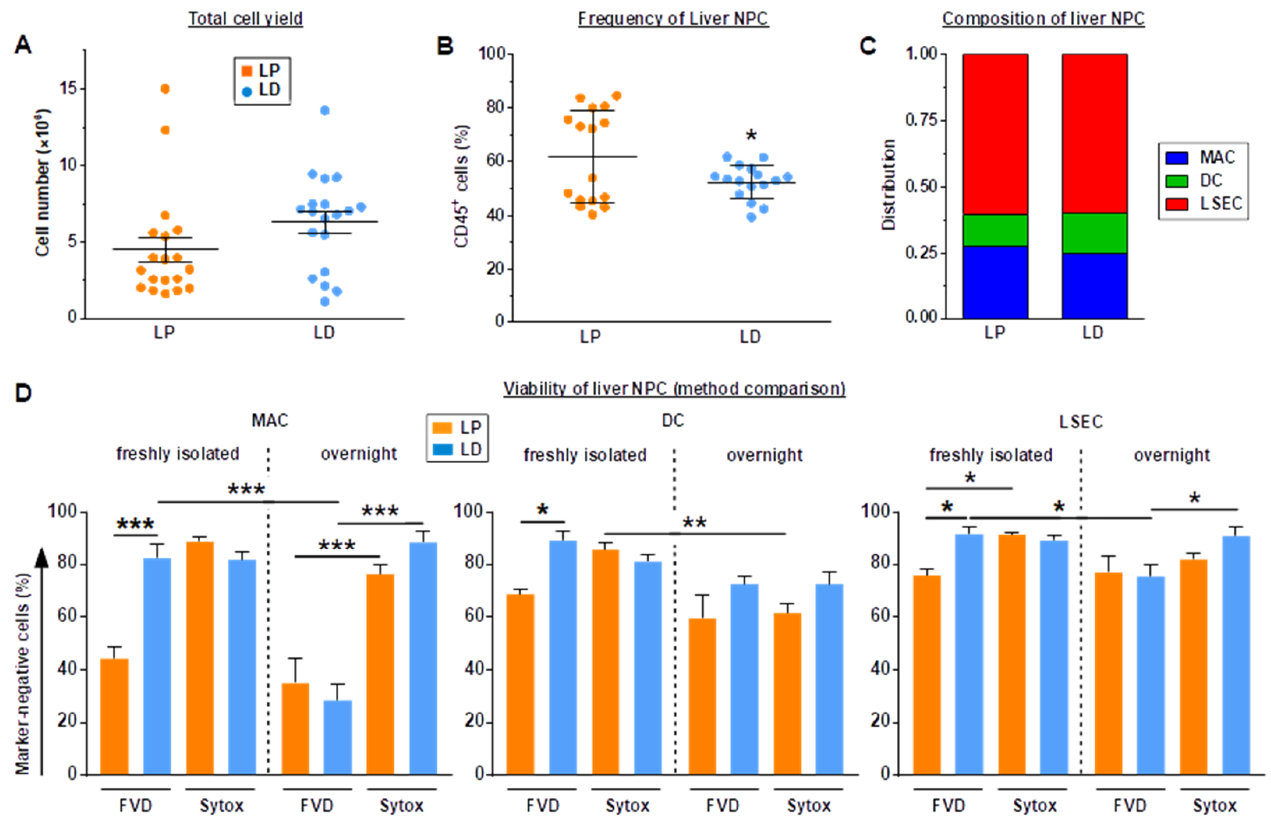
Figure 2. LP and LD yield comparable numbers and composition of liver NPCs, but LD-enriched cells appear dead when using FVD. ( A ) Total cell yield obtained after density centrifugation (mean ± SEM, each n = 19). ( B ) Frequencies of CD45 + cells within the enriched NPC suspensions were assessed by flow cytometry (mean ± SEM, each n = 19). ( C ) Composition of liver NPCs (CD11c + DCs, F4/80 + MACs, CD32b + LSECs) within the CD45 + cell population (mean, each n = 19; the gating strategy is shown in Figure S1). Statistically significant differences versus ( B ) *LP ( t -test) and ( D ) * between groups (two-way ANOVA/Tukey test) are indicated. * p < 0.05, ** p < 0.01, *** p < 0.001.